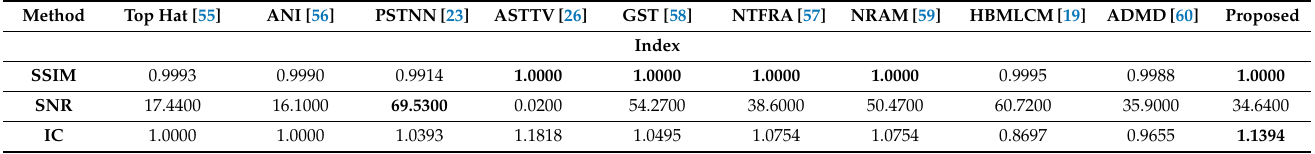
Table 8. Calculation of indicators in scenario D of each